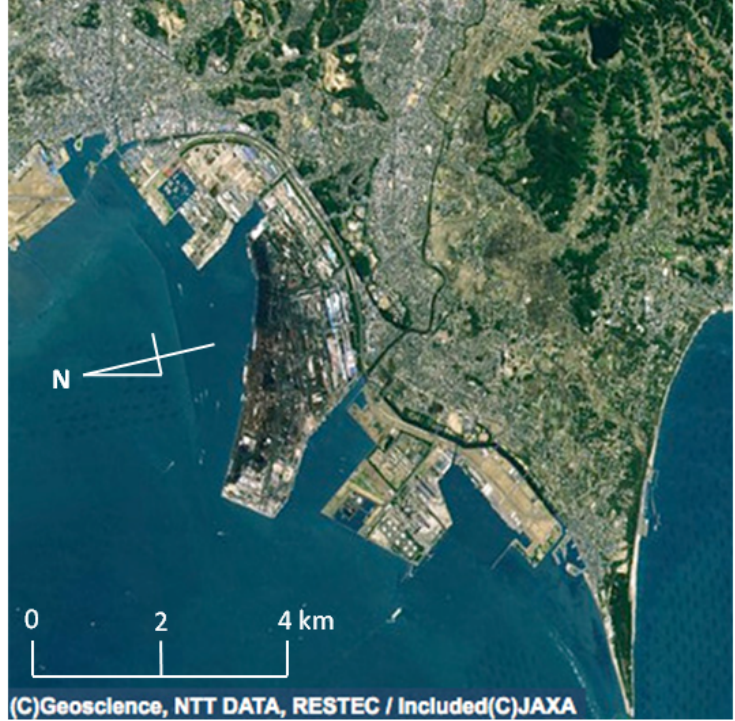
Figure 3. Optical photograph of the image corresponding to the area in Figure 2. The central coordinate of the image is approximately at (139 ◦ 52’E, 35 ◦ 20’N).